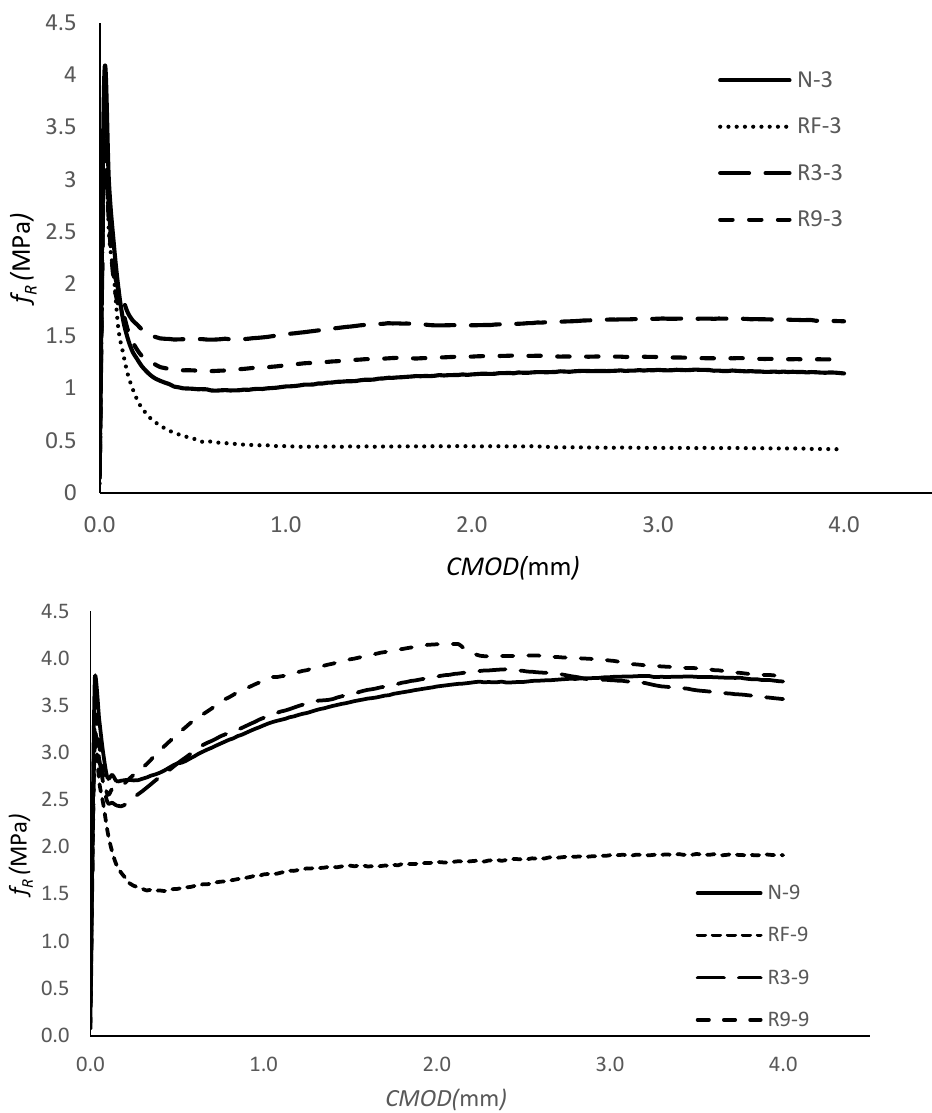
Figure 10. f R,j -CMOD curves of three-point bending tests: 3 kg/m 3 ( up ); 9 kg/m 3 ( below ); each line represents an average of 2 or 3 specimens. Table 5. Residual flexural tensile strength results.